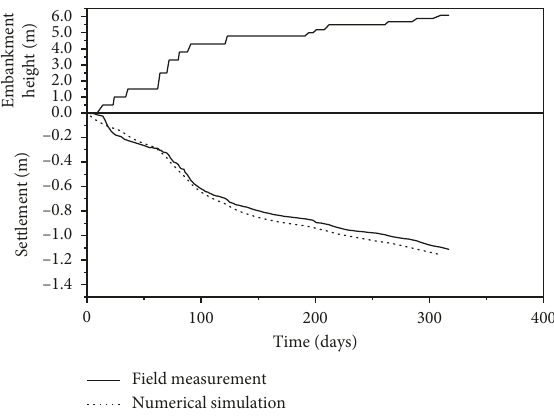
Figure 4: Comparison of measured and simulated settlements at the monitored site.